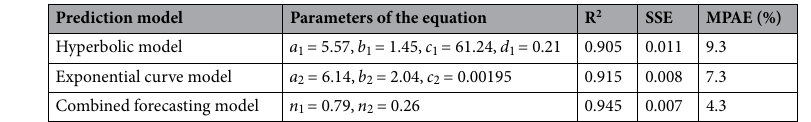
Table 3. Cumulative differential settlement prediction model of monitoring point 2.